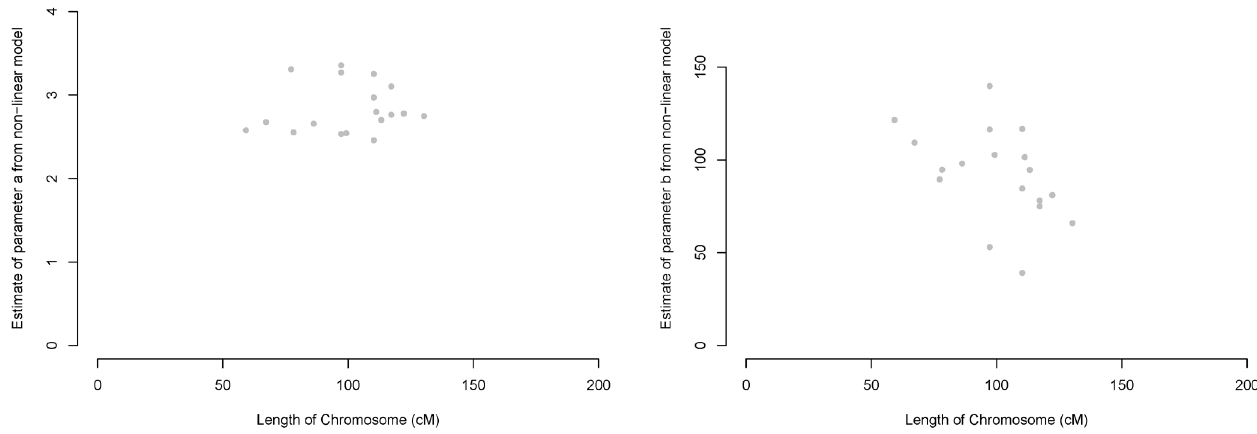
Figure 3. Parameter estimates from equation (3) vs chromosome length (cM) according to the porcine linkage map r 2 [26]. (a) Estimates of parameter a in equation (3) vs chromosome length (cM). (b) Estimates of parameter b in equation (3) vs chromosome length (cM).